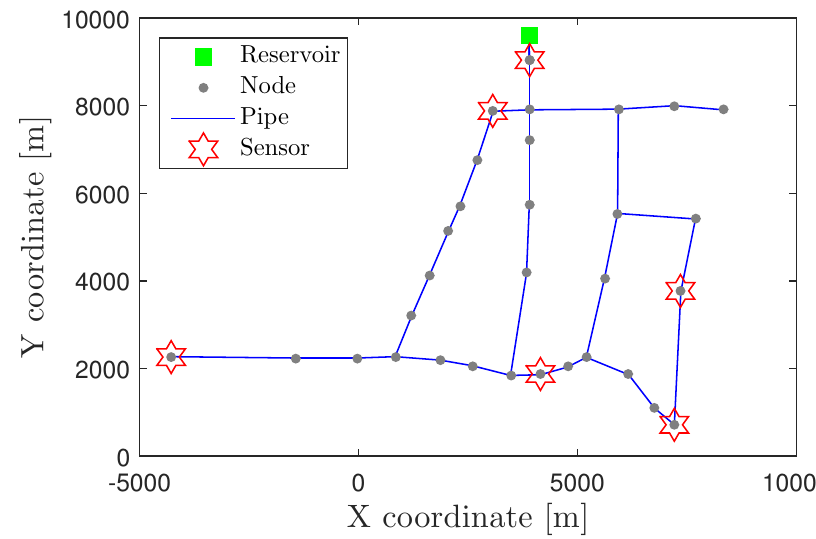
Figure 7. Sensor placement in the simplified Hanoi topological WDN.